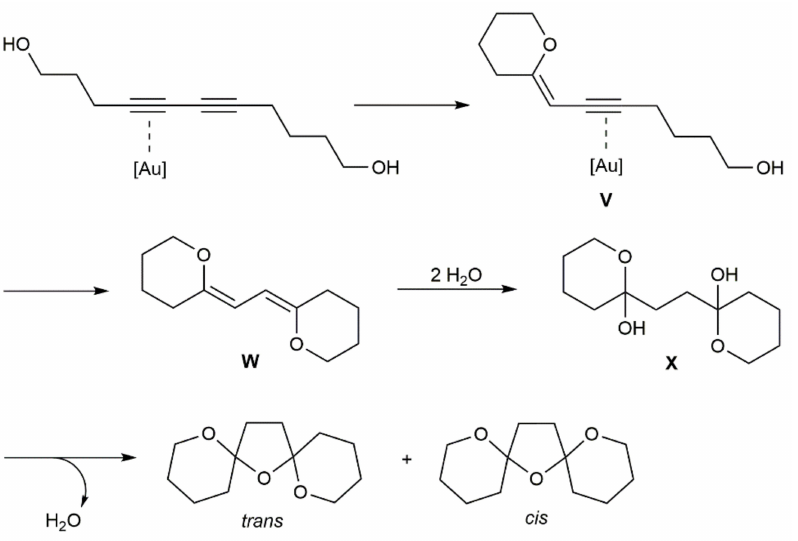
the related bis-spiroketals 113 – 115 were synthesized by Iglesias-Arteaga and colleagues through the hydroalkoxylation/hydration of the respective steroid-derived diynediols (Figure 15) [165]. The double spiroacetalization process proceeded in high yields ( ≥ 68%) and produced almost exclusively the C 2 symmetrical trans distereoisomers (only in the case of 115 was a small amount of the unsymmetrical cis isomer formed). DFT calcula- tions indicated a higher stability of the trans vs. cis diastereoisomers for these particular compounds ( ca. 4 Kcal/mol), with the fusion of the side tetrahydropyrane rings to rigid scaffolds suppressing the conformational equilibrium between both